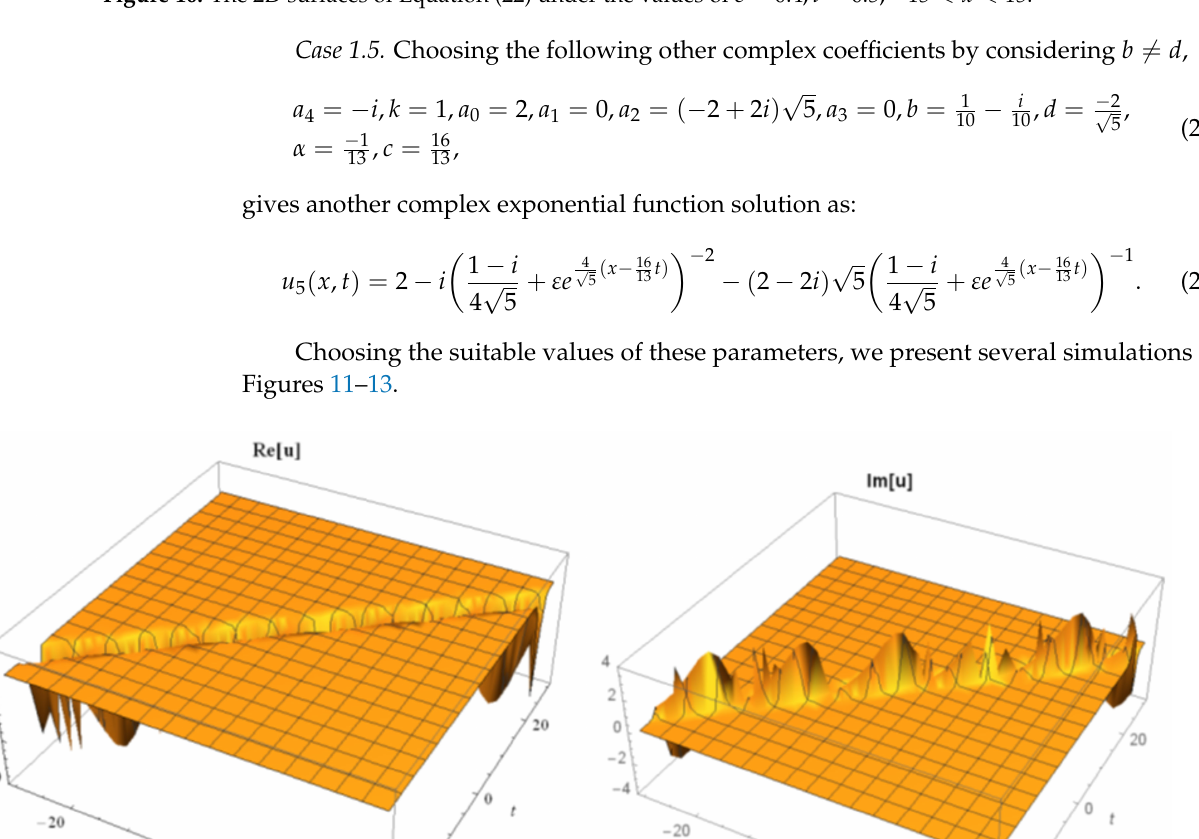
Figure 10. The 2D surfaces of Equation (22) under the values of ε = 0.4, t = 0.5, − 15 < x < 15.